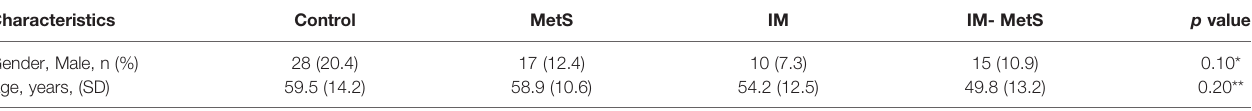
TABLE 1 | Study participants ’